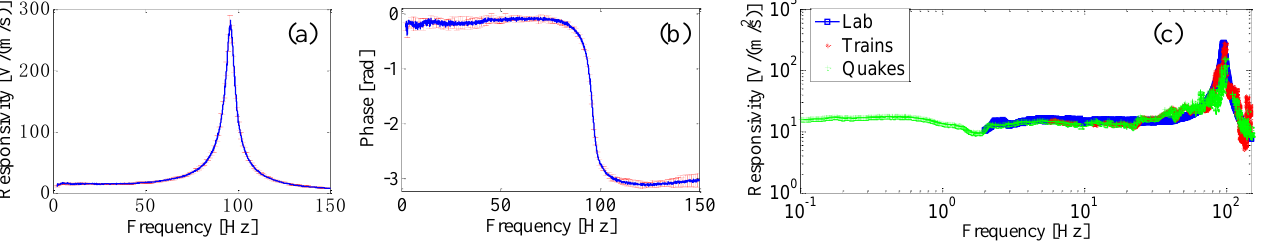
Figure 14. ( a ) Mean responsivity based on ten measurements and relative error bars for the optical fiber sensor in terms of the amplitude and ( b ) phase. ( c ) Comparison among the experimental responsivities of the LOF sensor retrieved by using Lab experiments (blue line) and by using natural sources of vibration like trains (red line) and earthquakes (green line). Reproduced with permission from ref [70] (the figure is released under a CC-BY-SA license http://creativecommons.org/licenses/by/4.0/ (https://www.nature.com/articles/s41598-018-25082-8 (accessed on 27 April 2018)).